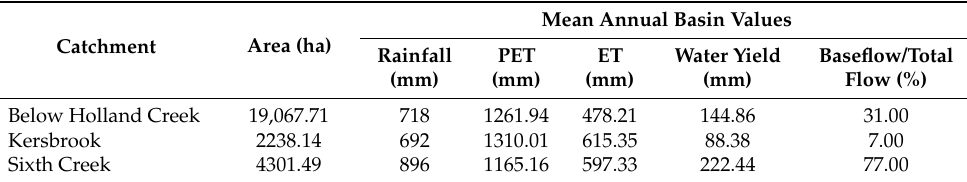
Table 3. Water budget components of the study